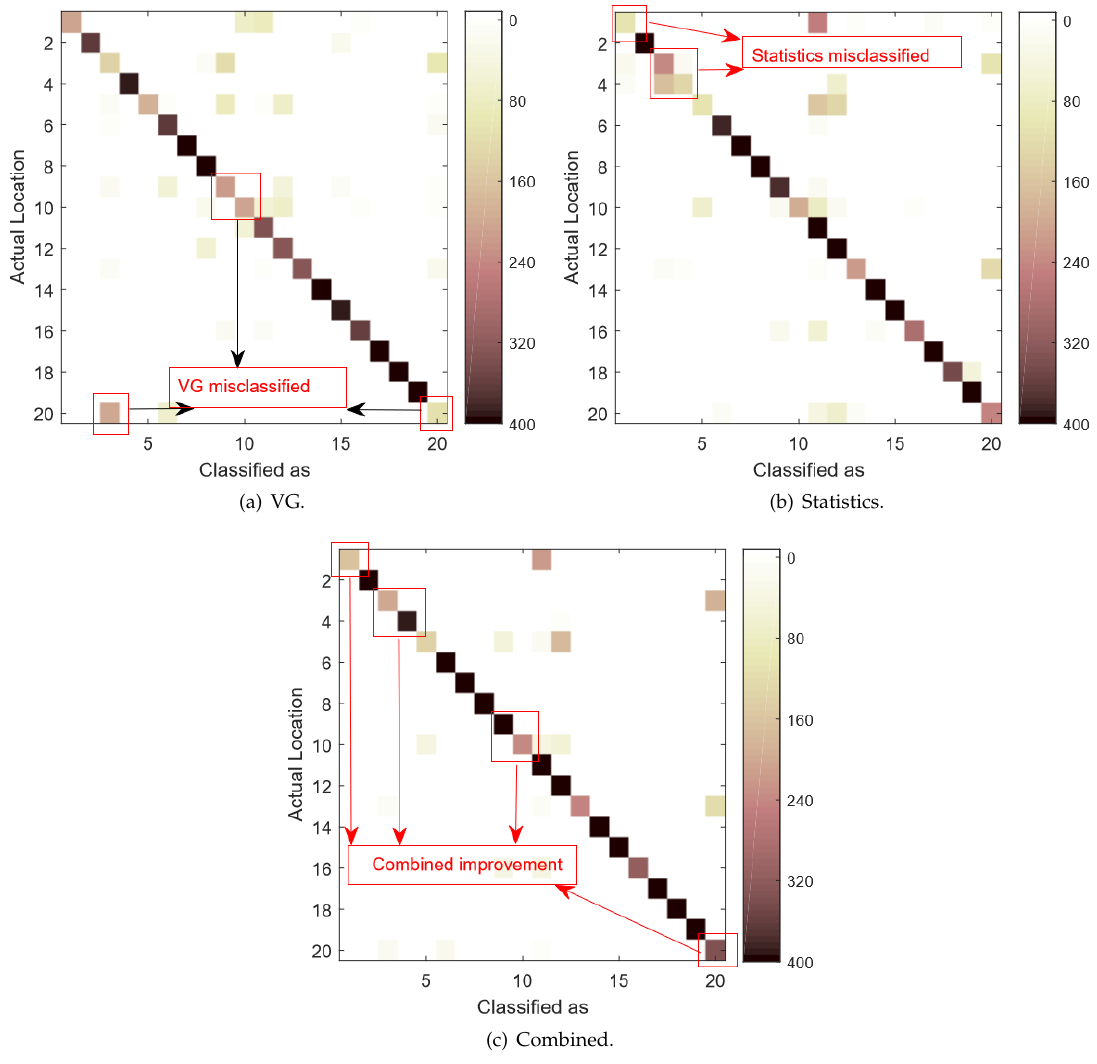
Figure 8. The confusion matrices of different